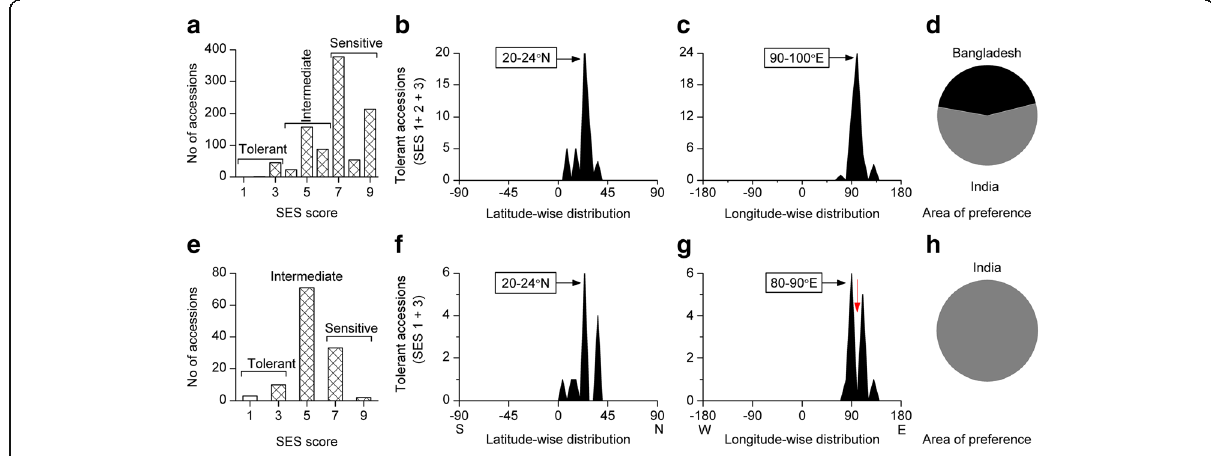
Fig. 3 Geographic distribution pattern of zinc deficiency tolerant rice accessions. a - d Zinc-deficient field screening, a Extent of tolerant accessions b Latitude-wise distribution, c Longitude-wide distribution, d Area of preference, e - h Greenhouse screening, e Extent of tolerant accessions, f Latitude-wise distribution, f Longitude-wide distribution, g Area of preference. List of highly tolerant accessions can be found in Additional file 4: Table S1